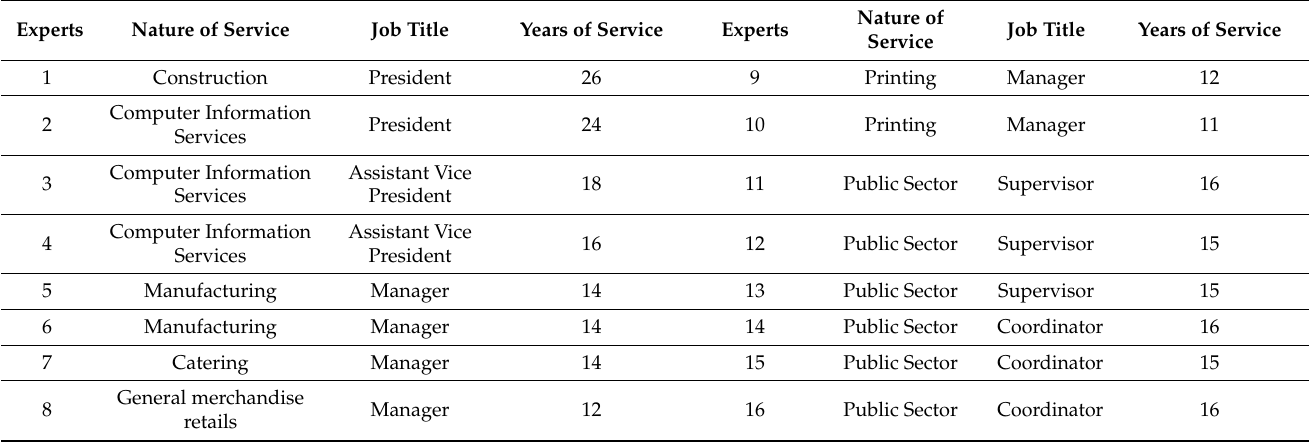
Table 11. Expert